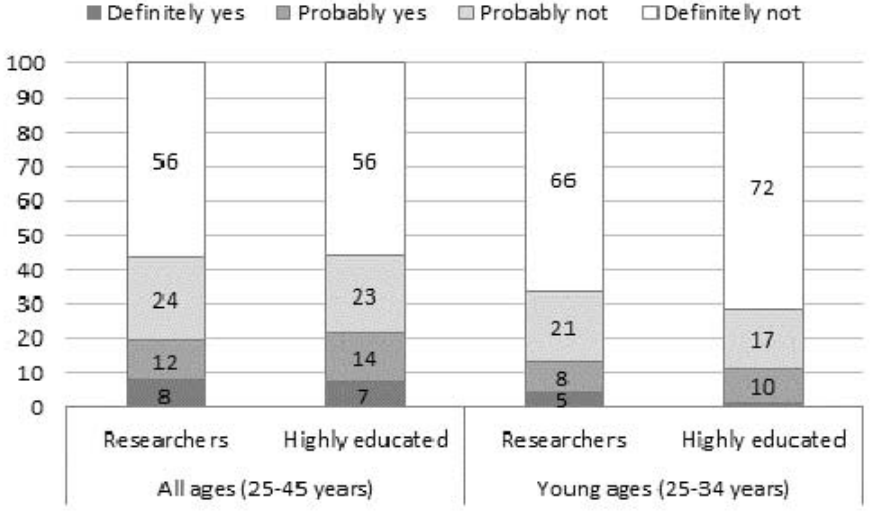
Figure 2 : Certainty of intention to stay childless among childless female researchers and other highly educated women (in